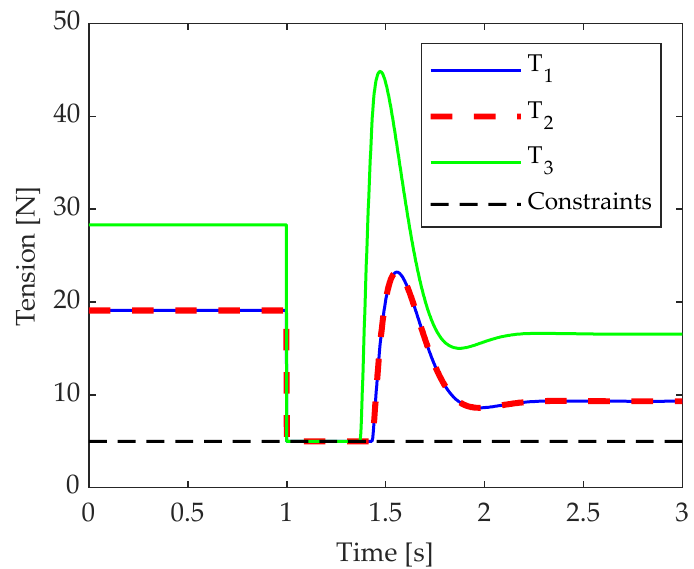
Figure 3. Cable tensions with the position step reference.